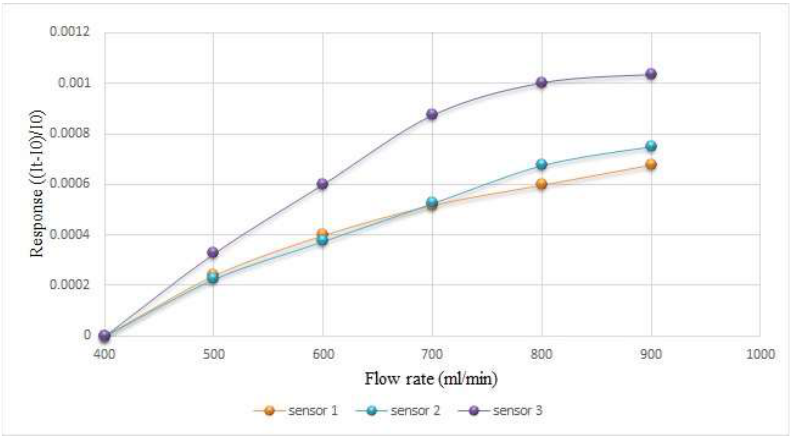
Figure 8. Calibration of micro flow sensor in oxygen state.